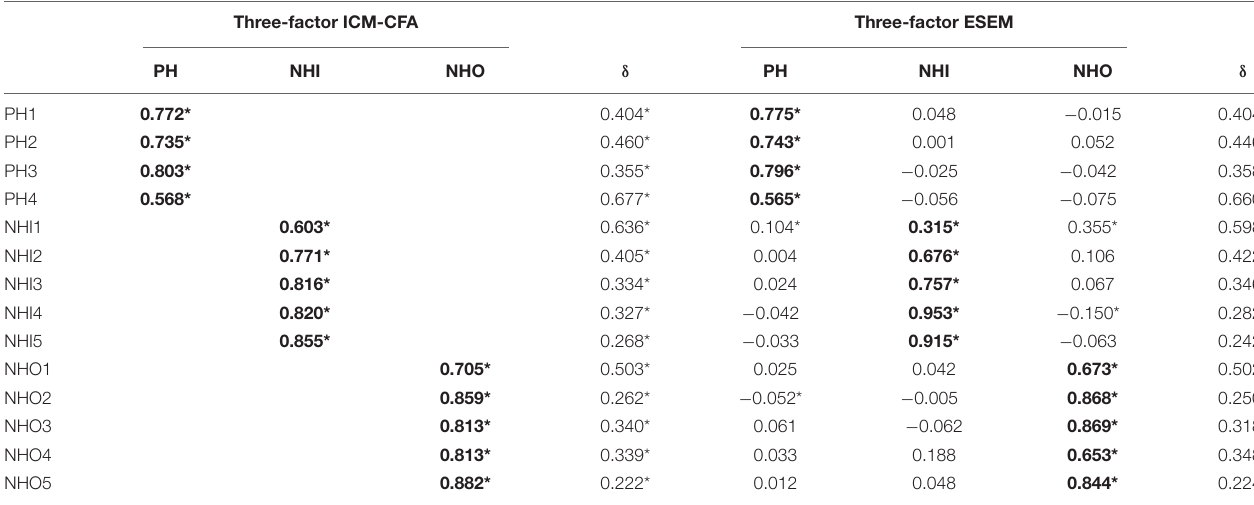
TABLE 5 | Factor loadings for ICM-CFA and ESEM (sample